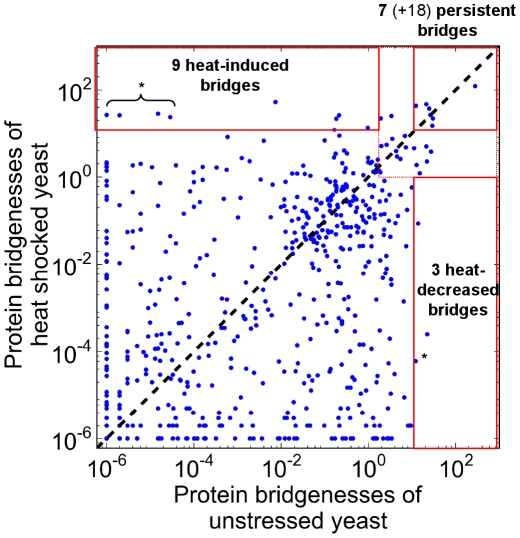
Heat shock-induced changes of bridgeness of yeast proteins.Protein-protein interaction networks of unstressed and heat shocked (15 min heat shock at 37°C) yeast cells were created and the bridgeness of their proteins was determined as described earlier [8]. Proteins having zero bridgeness values in one of the conditions were excluded from subsequent analysis. Red boxes denote those proteins, which had a large bridgeness only after heat shock (top red box containing 9 heat-induced bridges); only before heat shock (left red box containing 3 heat-decreased bridges); or were persistent bridges in both conditions (red box in top right corner containing 7 persistent bridges, as well as red dotted box in top right corner containing an additional 18 persistent, albeit less dominant bridges). Proteins were marked by asterisk, if their bridgeness induction or reduction were more than 105-fold. Names and functional annotations of the bridges in the red boxes are listed in Table S4 of Text S1. The position of the 7 persistent and 9 heat shock-induced bridges in the yeast interactome containing the strongest links is shown on Figure S6 of Text S1.